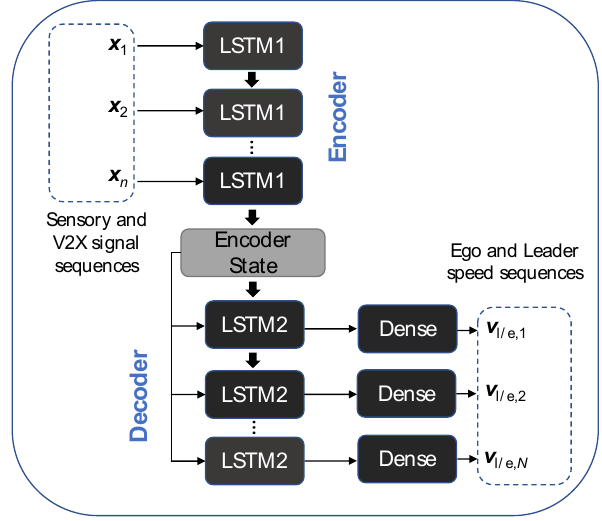
Figure 7. Architecture of the neural prediction model.